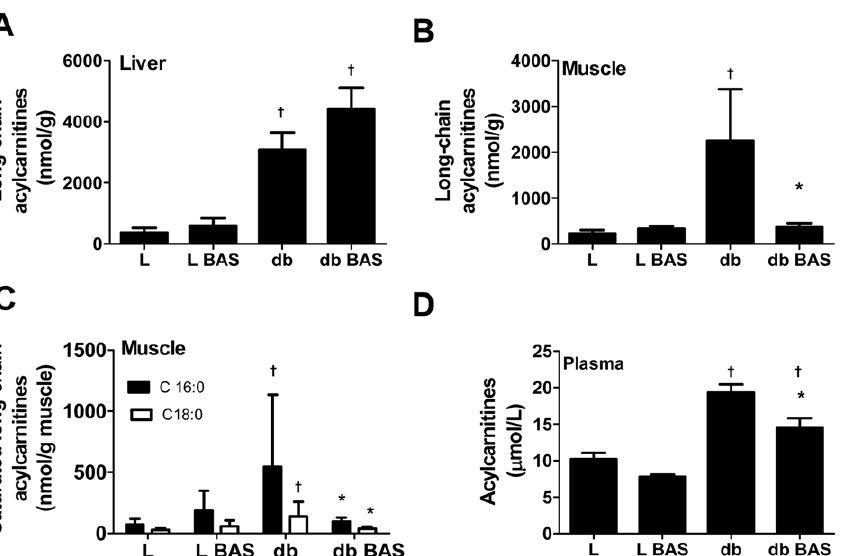
Figure 1. Effect of BAS on liver, skeletal muscle and plasma acylcarnitines. Effect of BAS on hepatic long-chain acylcarnitines content (Sum of C16:0, C16:1, C18:0, C18:1 and C18:2) (A), skeletal muscle long-chain acylcarnitines content (B), skeletal muscle saturated long-chain acylcarnitines content (C) and plasma acylcarnitine concentration (D) in lean mice (L, (n=5), lean mice supplemented with BAS (L BAS, n=4), db/db mice (db, n=5) and db/db mice supplemented with BAS (db BAS, n=5). Data are mean 6 SD; { p , 0.05 vs. L same condition; * p , 0.05 vs . same genotype untreated.